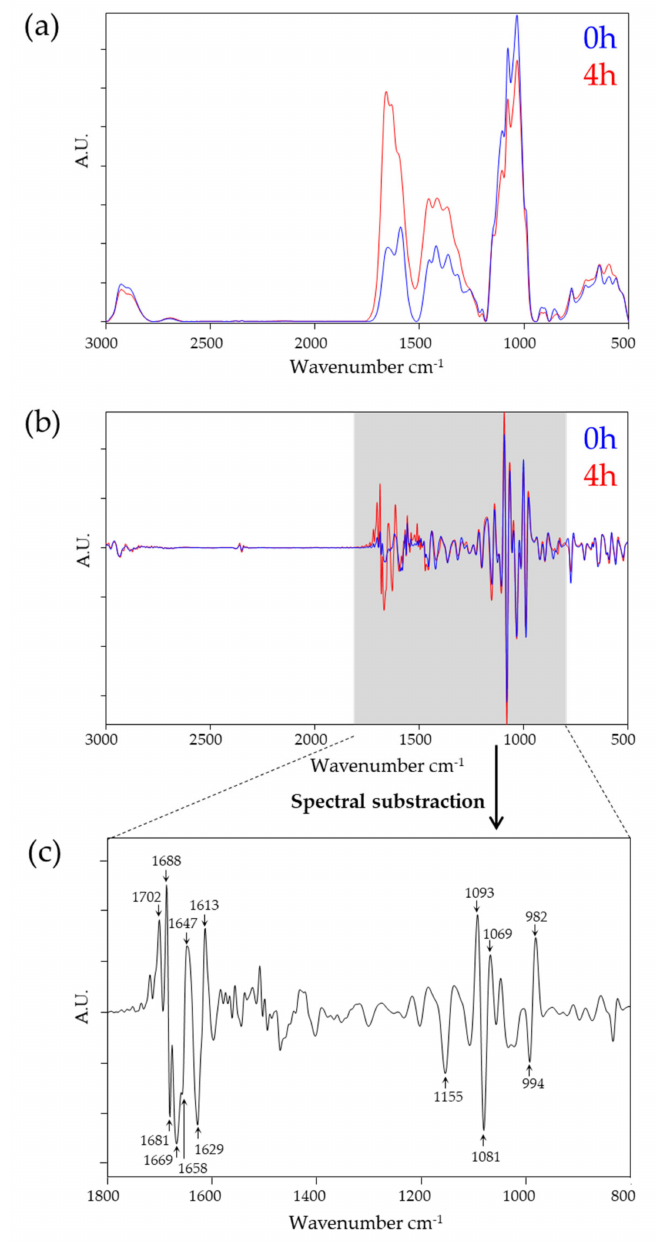
Figure 1. Spectral comparison of 0 h and 4 h peritoneal dialysis (PD) e ffl uent samples. ( a ) Average spectra of vector-normalized, baseline corrected spectra (0 h, n = 39; 4 h, n = 40). ( b ) Average spectra of second derivative, baseline corrected spectra (0 h, n = 39; 4 h, n = 40). ( c ) Subtraction spectra generated of second derivative, baseline corrected spectra at the relevant spectral range of 1800–800 cm − 1 . Spectra from 4 h were subtracted from 0 h. Wavenumbers responsible for discrimination are indicated. A.U., arbitrary